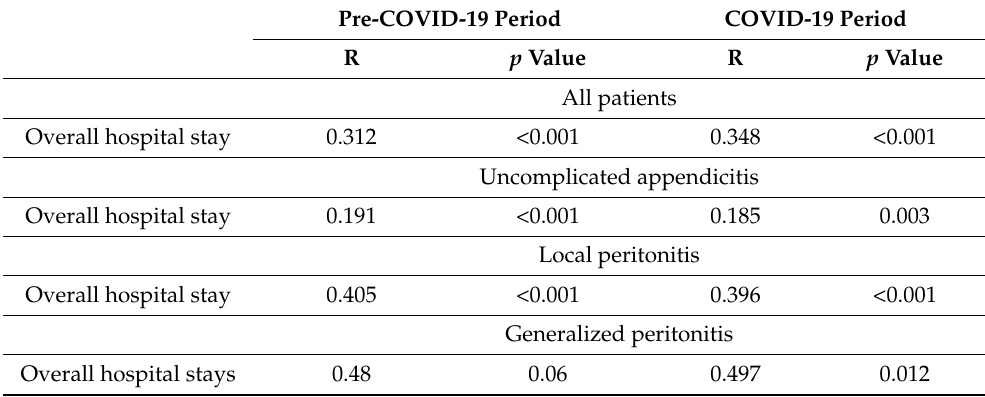
Table 5. Correlation analysis between patients age and overall hospital